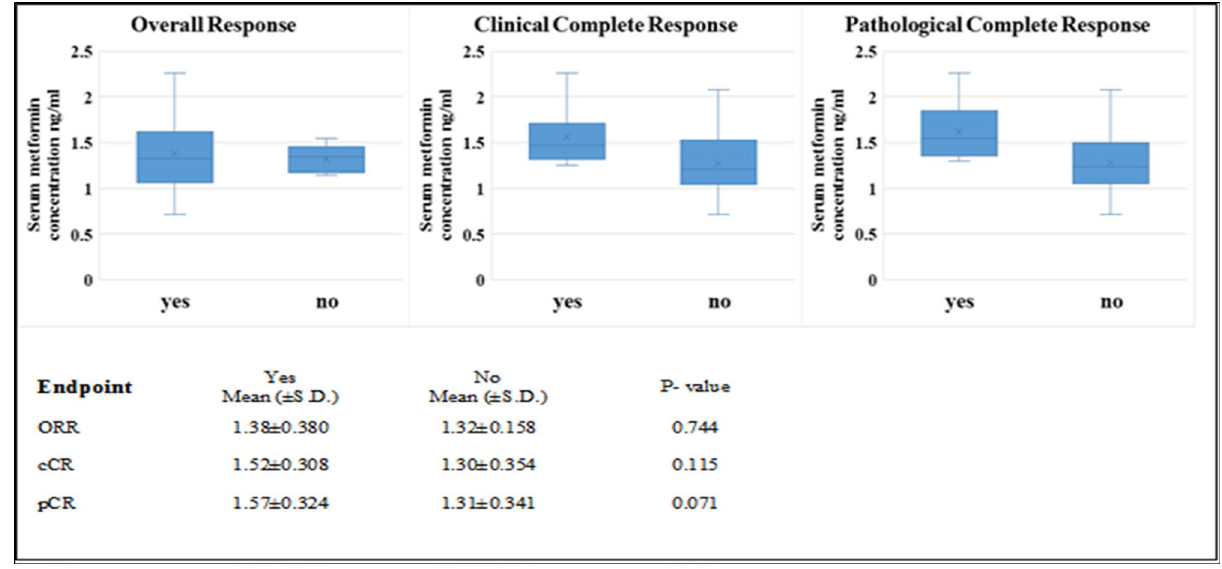
Figure 3. Box plot and whiskers of the relation between serum metformin level and the response of the different endpoints.